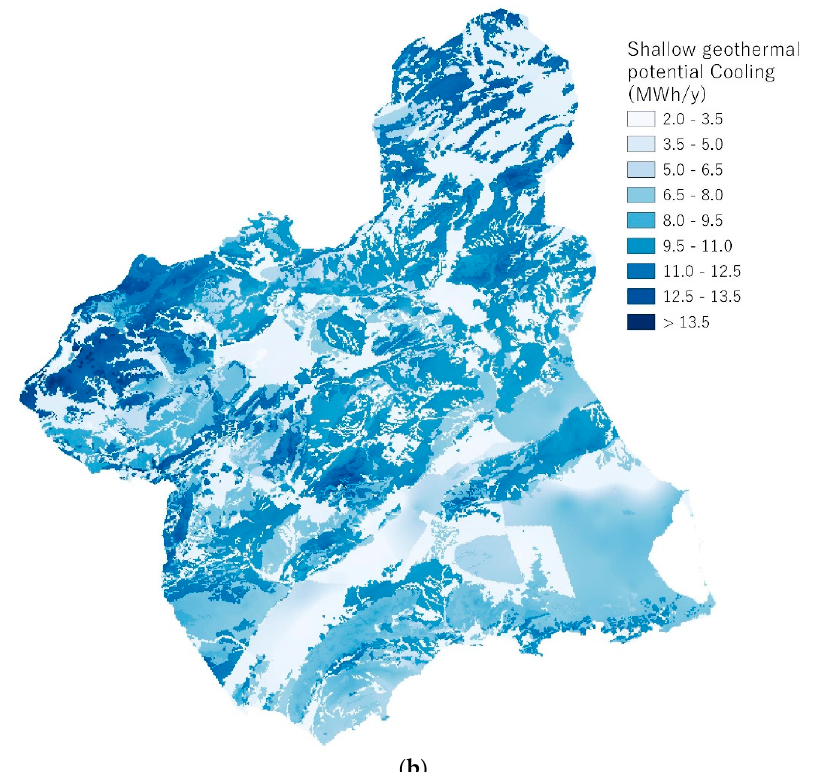
Figure 6. Map of the shallow geothermal potential for space heating (a) and space cooling (b) in the Region of Murcia with the G.POT method up to 100 m depth.